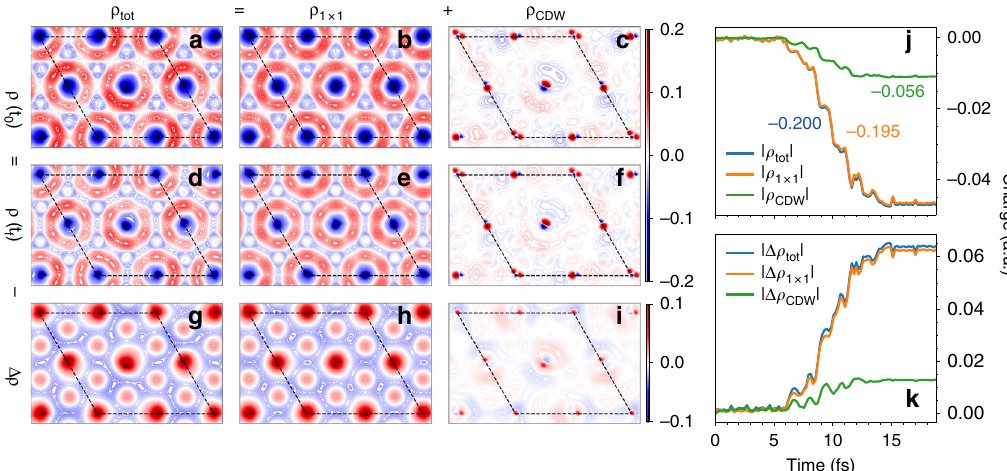
ð x ; y ; t Þ , b ρ ð x ; y ; t Þ , c ρ ð x ; y ; t Þ , d ρ ð x ; y ; t Þ , e ρ ð x ; y ; t Þ , f ρ ð x ; y ; t Þ , f f f 0 0 0 1 ´ 1 1 ´ 1 tot CDW tot CDW